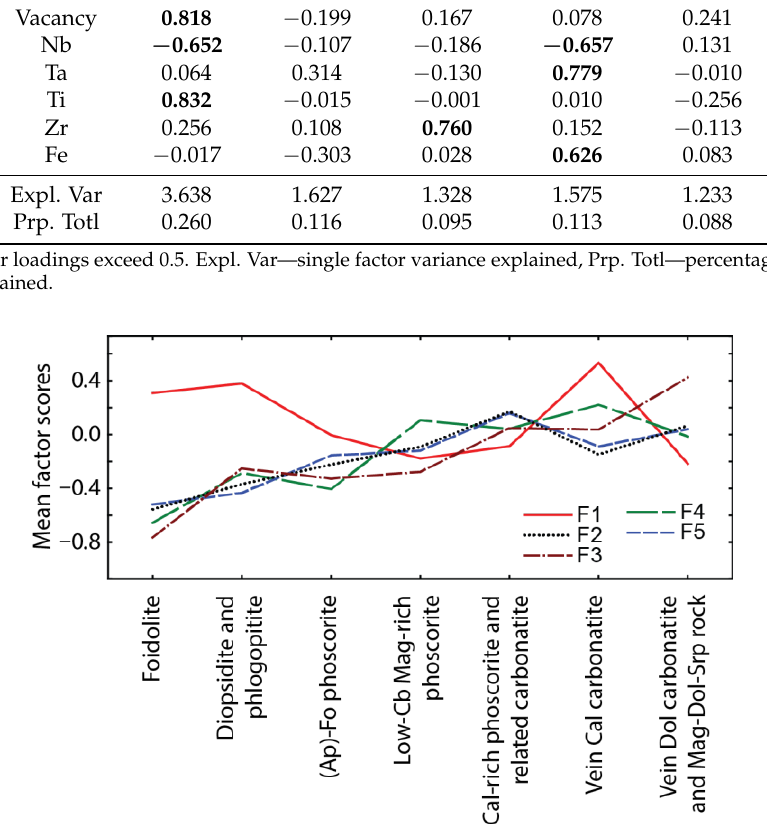
Figure 7. Changes of mean factor scores reflected PSM composition (see Table 5) in natural sequence of the Kovdor rocks.